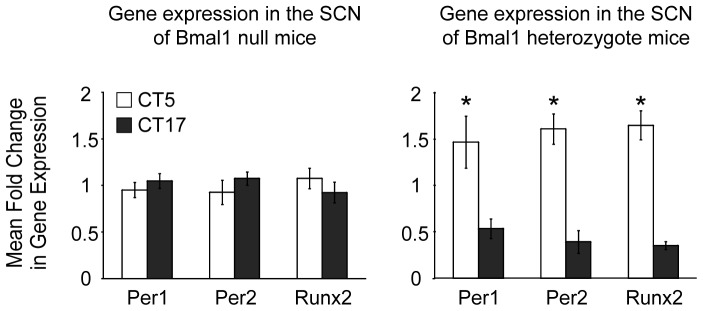
Diurnal changes in Runx2 gene expression are absent in Bmal1−/− but not Bmal1+/− mouse SCN.Fold changes in mRNA levels (± SEM) of Per1, Per2, Runx2 and Runx1 determined by real-time qRT-PCR under DD conditions. Values represent the level of normalized gene expression relative to the mean overall normalized gene expression at observed times of day. *: significant difference in levels of gene expression between times of day; p<0.05.